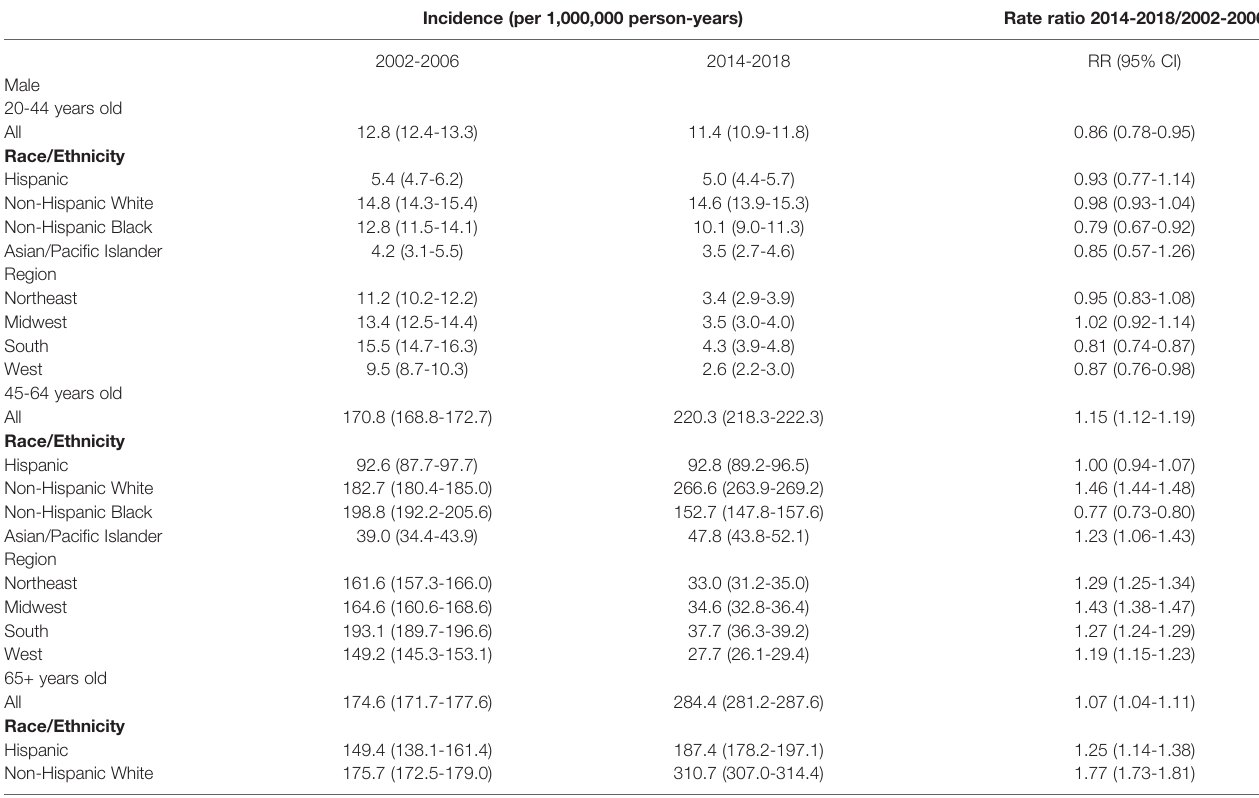
TABLE 1 | Age-adjusted incidence of HPV-related oropharyngeal squamous cell carcinoma (OPSCC) among US adults by age group and sex during 2002-2006 and